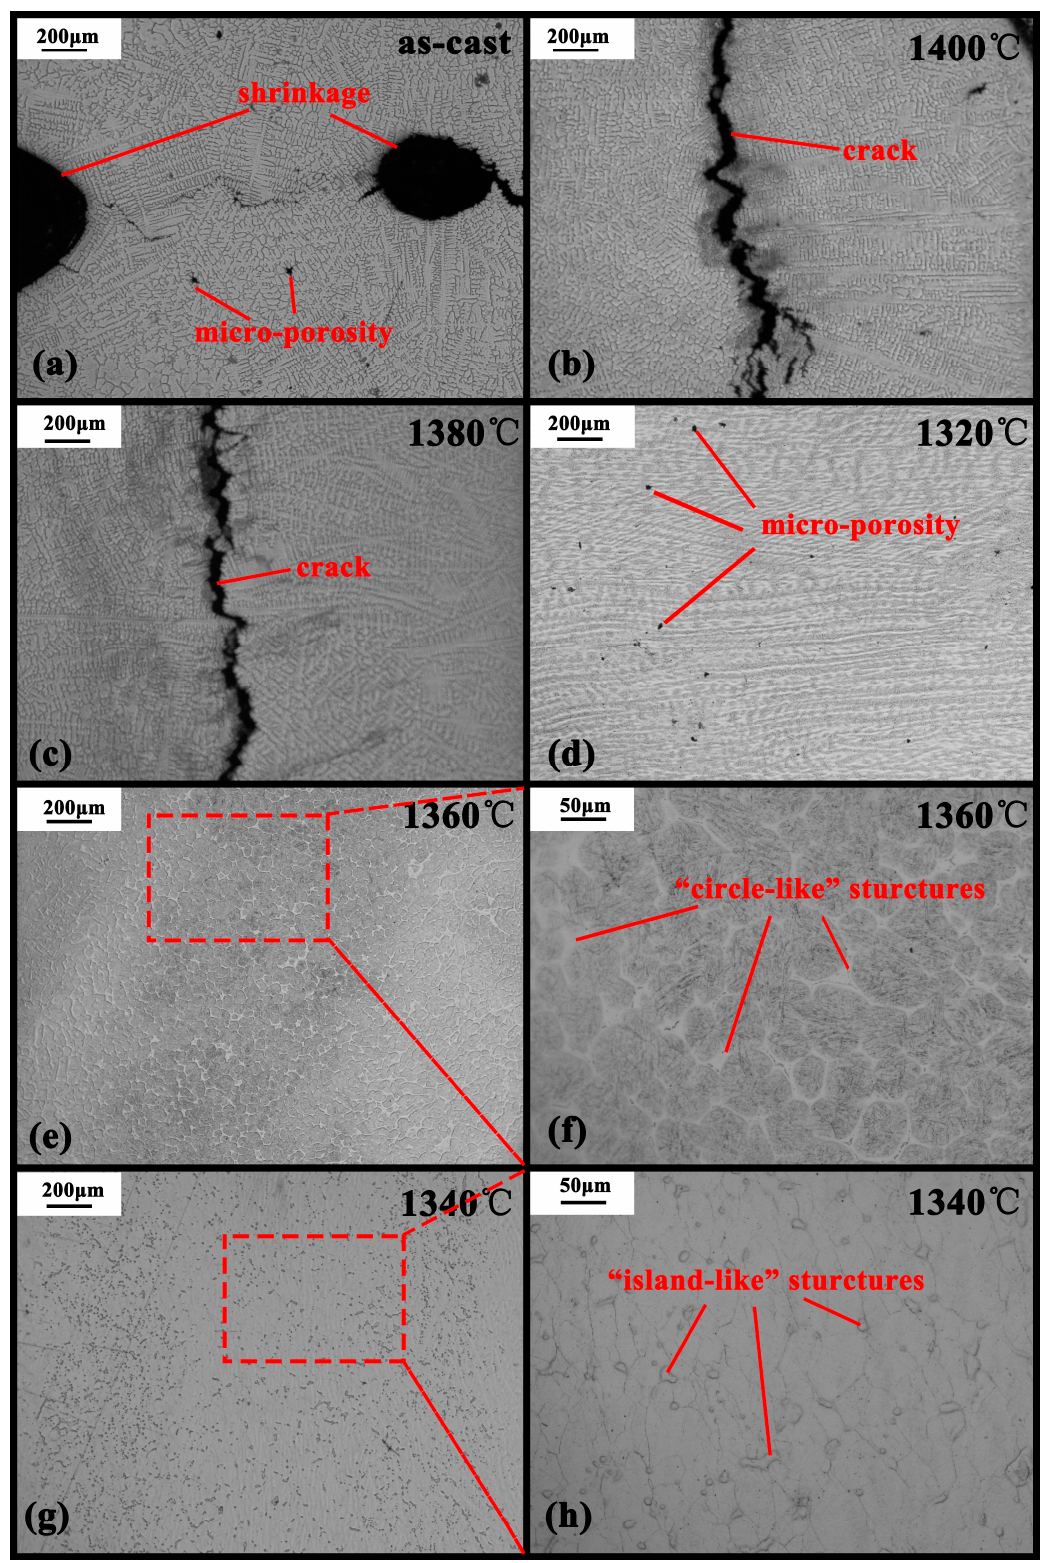
Figure 5. Microstructures of the specimens under different experimental conditions in this study. ( a ) As-cast state; ( b – h ) compressed specimens at different F L ; ( f , h ) are the local magnification of the microstructures in ( e , g ), respectively.